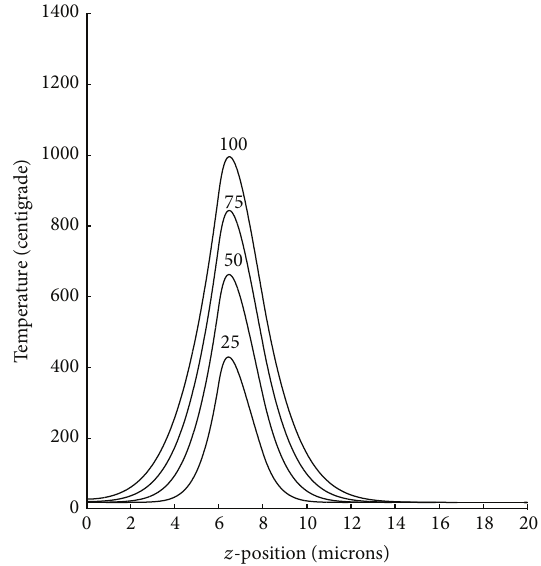
Figure 2: Temperature profiles on 𝑥 = 2.5 𝜇 m, 𝑦 = 0 as a function of 𝑧 at times − 100, − 50, 0, 50, 100, and 200 𝜇 s.